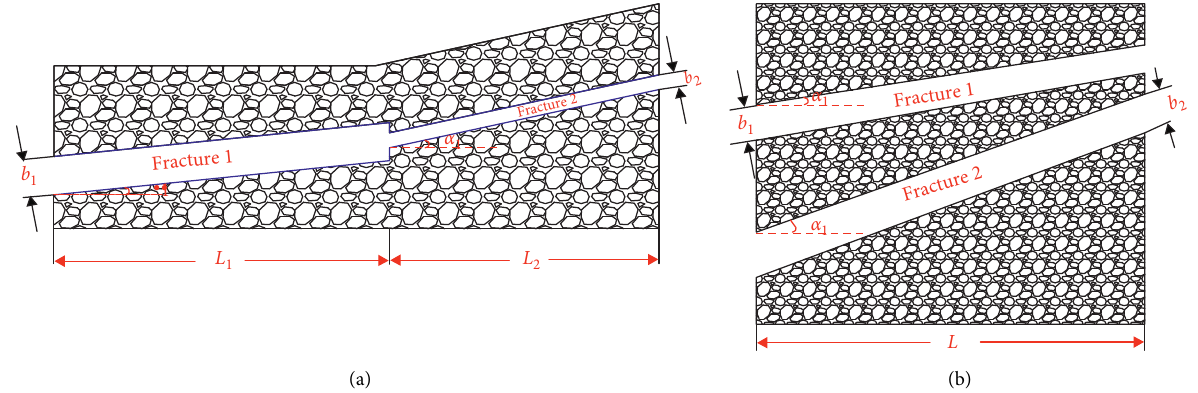
Figure 2: Schematic diagram of the fracture in tandem structure. (a) Series fracture structure. (b) Parallel fracture